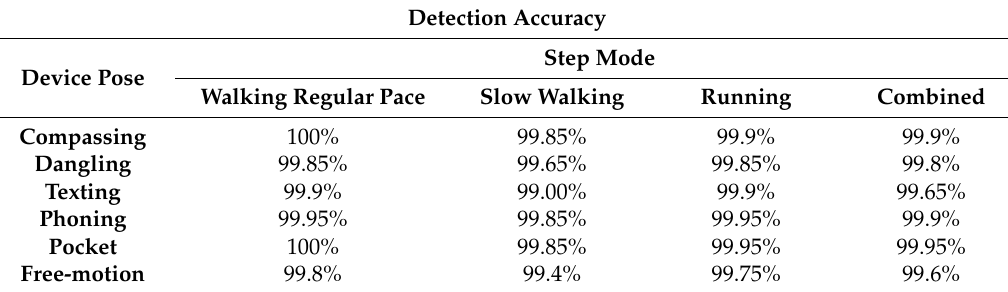
Table 3. Average accuracy of the proposed algorithm.